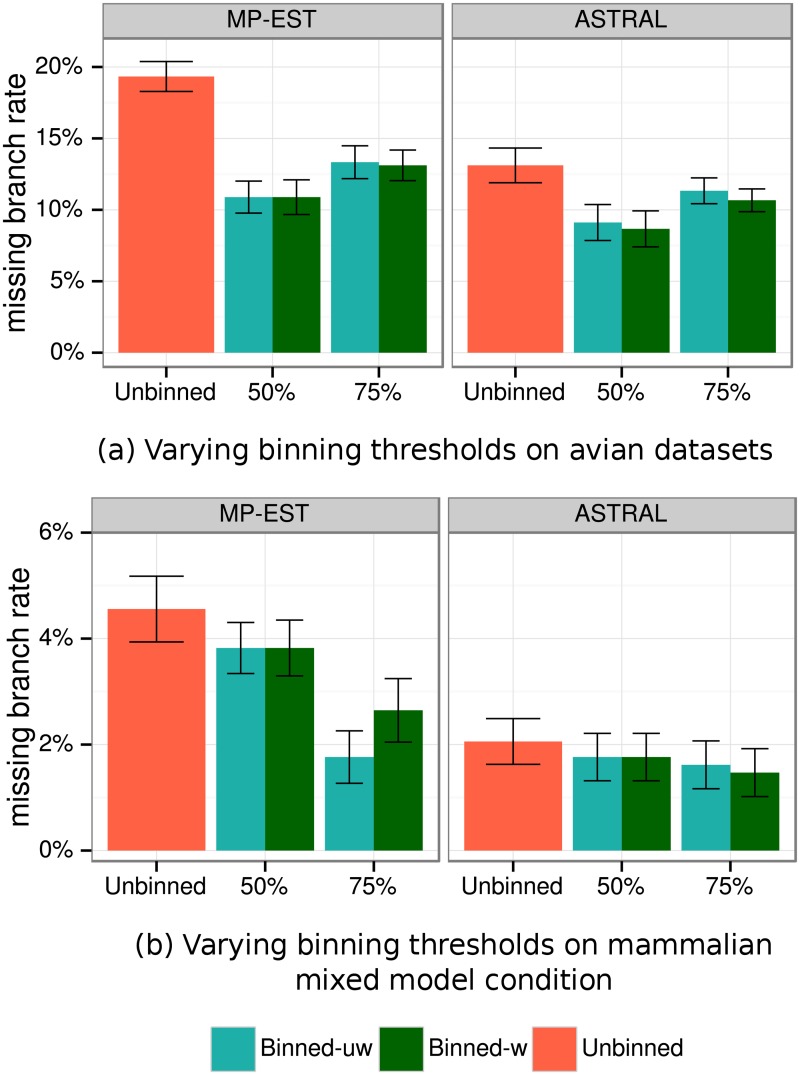
Species tree estimation error for MP-EST and ASTRAL using MLBS on avian and mammalian simulated datasets with two support thresholds (B).We show average FN rate for unbinned, and wighted and unweighted binned analyses with both B = 50% and B = 75%. Results are shown for (a) the avian dataset with 10 replicates of 1000 genes of length 500bp and 1X ILS level, and (b) the mammalian dataset with 20 replicates of 400 mixed genes (200 genes with 500bp and 200 genes with 1000bp) with 1X ILS level.